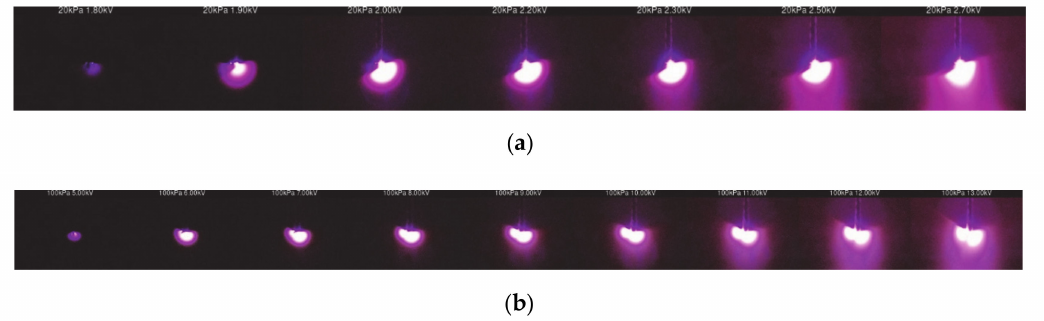
Figure 5. Negative DC corona images taken at di ff erent conditions. ( a ) At 20 kPa applying from left to right 1.8 kV, 1.9 kV, 2.0 kV, 2.2 kV, 2.3 kV, 2.5 kV and 2.7 kV. ( b ) At 100 kPa applying from left to right 5.0 kV, 6.0 kV, 7.0 kV, 8.0 kV, 9.0 kV, 10.0 kV, 11.0 kV, 12.0 kV and 13.0 kV.